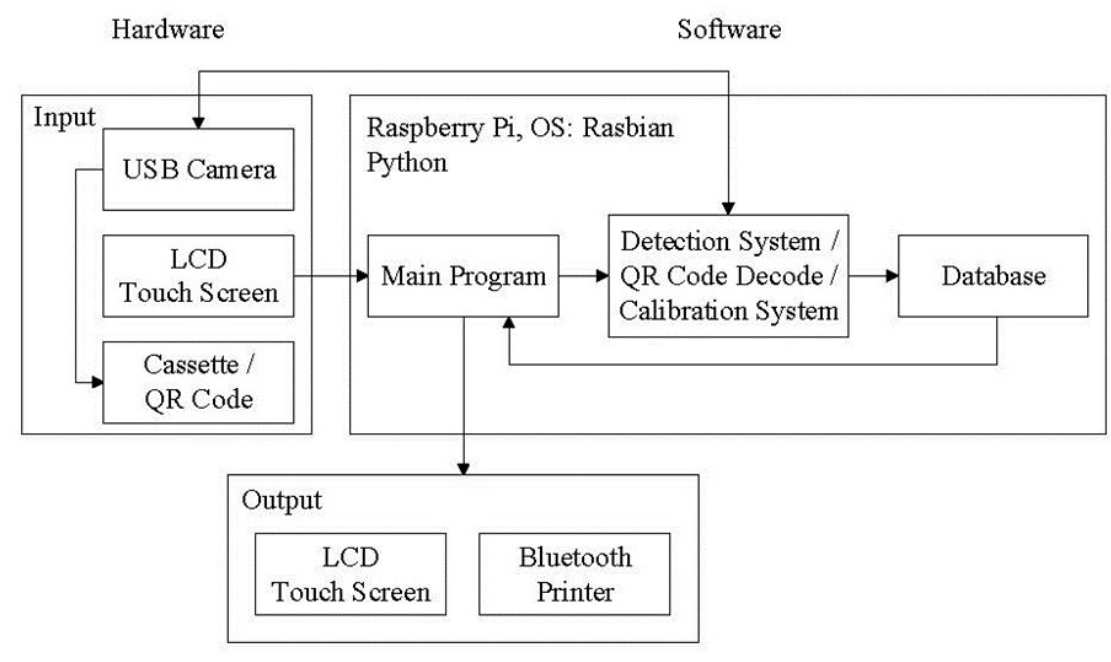
Figure 2. Schematic flow chart of the system signal.